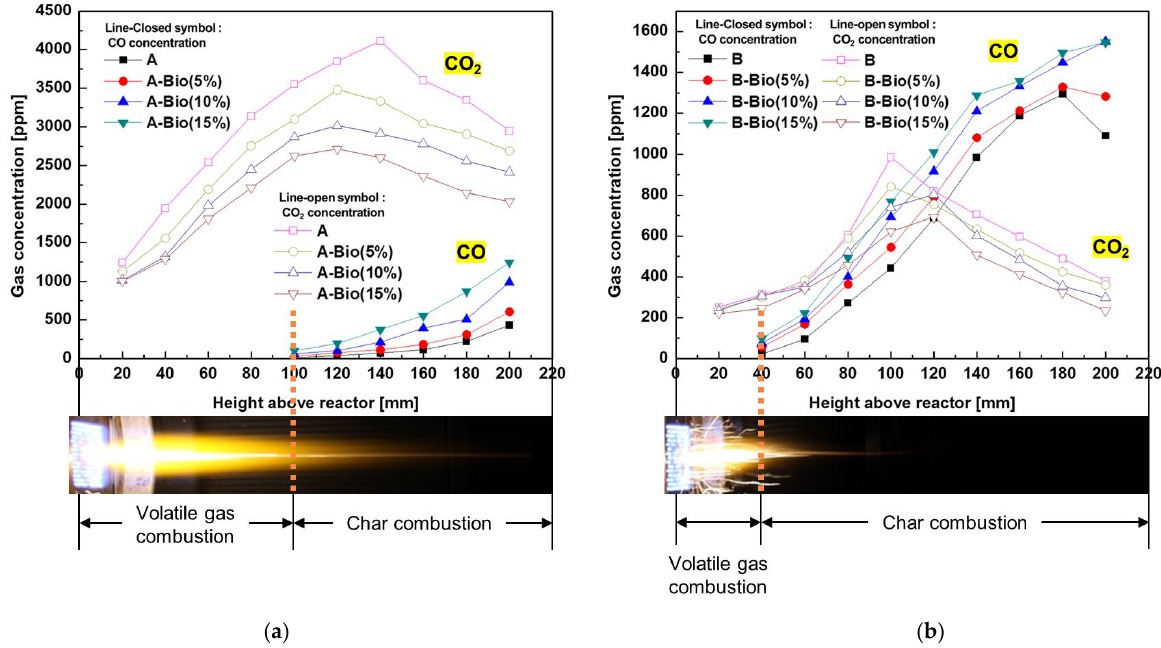
Figure 7. CO/CO 2 emission gas concentration distribution along the height above the reactor: ( a ) Coal A + biomass (0%, 5%, 10%, 15%) and ( b ) Coal B + biomass (0%, 5%, 10%, 15%).